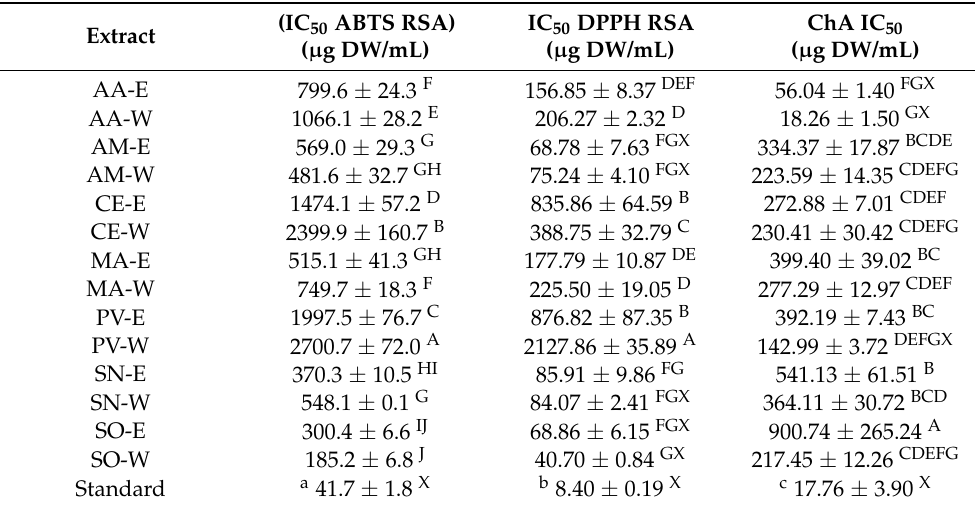
The extracts’ abbreviations are presented in Table 2; Standards: a = Trolox, b = BHA, c = EDTA; DW—dry weight of the extract; Values are an average of three replications ± SD; A–J = differences between the extracts within a column (extracts not connected with the same capital letter are statistically different, Tukey post-test, p < 0.05); X = differences with the positive control within a column (extracts not connected with the same capital letter are statistically different, Dunnet’s post-test, p <